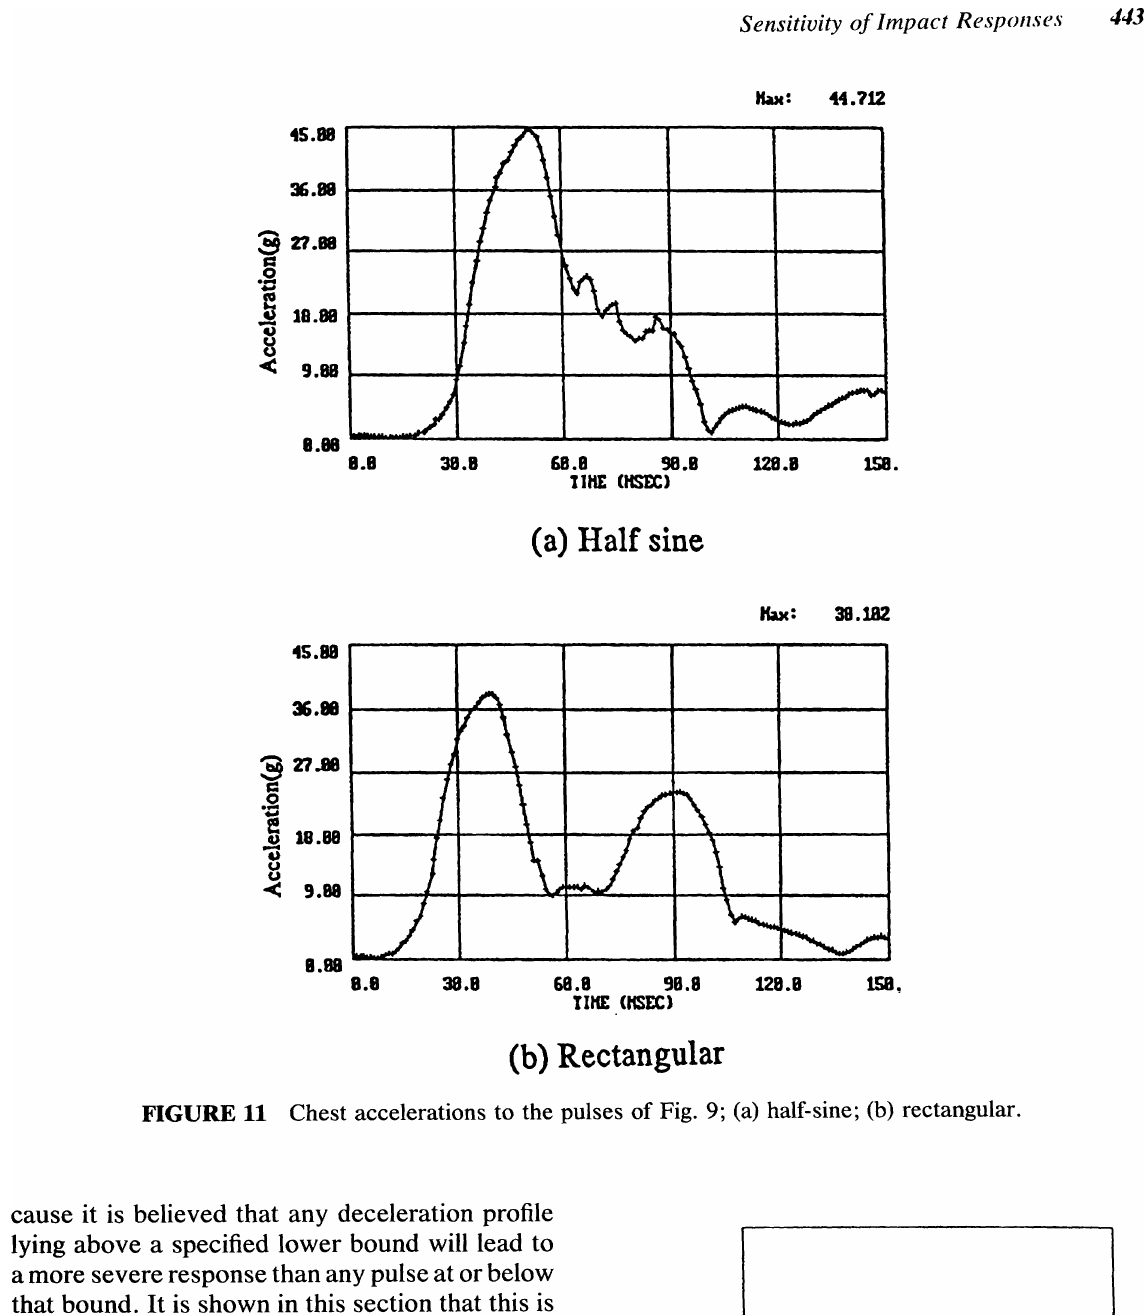
FIGURE 11 Chest accelerations to the pulses of Fig. 9; (a) half-sine; (b) rectangular.